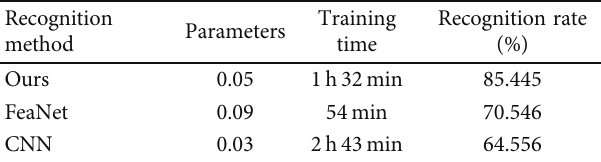
Table 1: Comparative results of three